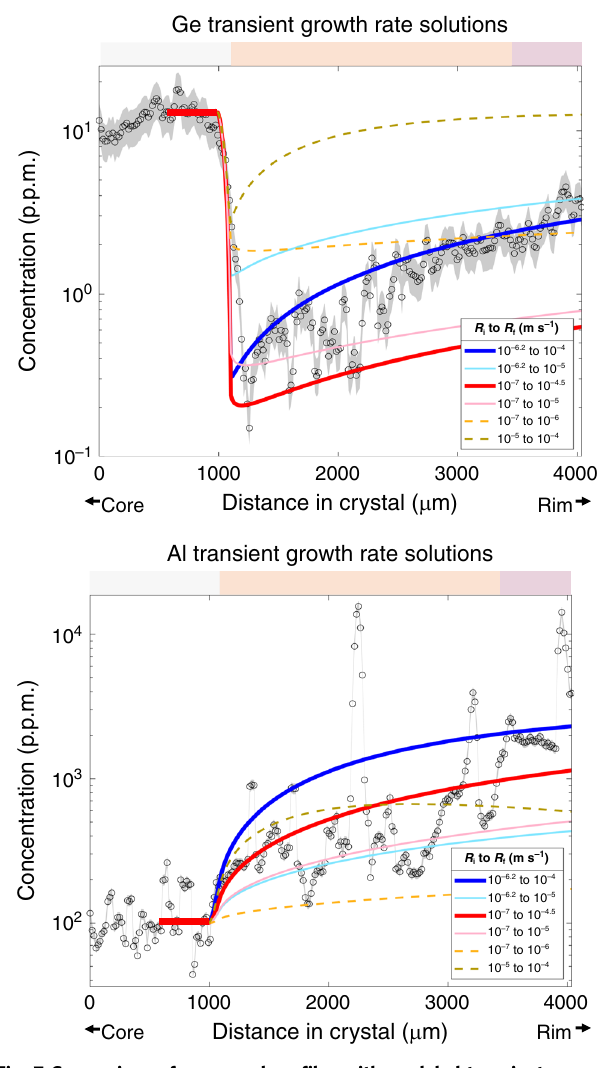
Fig. 7 Comparison of measured pro fi les with modeled transient responses. Solutions for transient responses for Ge and Al. Curves represent the response for a step function change in the crystal growth rate from R i to R f at ~1000 μ m (the orange-white transition). A 2 – 2.5 order of magnitude change in growth rate is needed to match the data. Al should eventually reach a peak and fall back to steady state, yet the crystal did not grow long enough for this to occur. Color bar on top corresponds with CL color zones in crystal. Error envelopes represent standard error of the mean based on 3 σ of point analyses and a three-point moving average. The error values are 26% and 8.5% for Ge and Al, respectively.